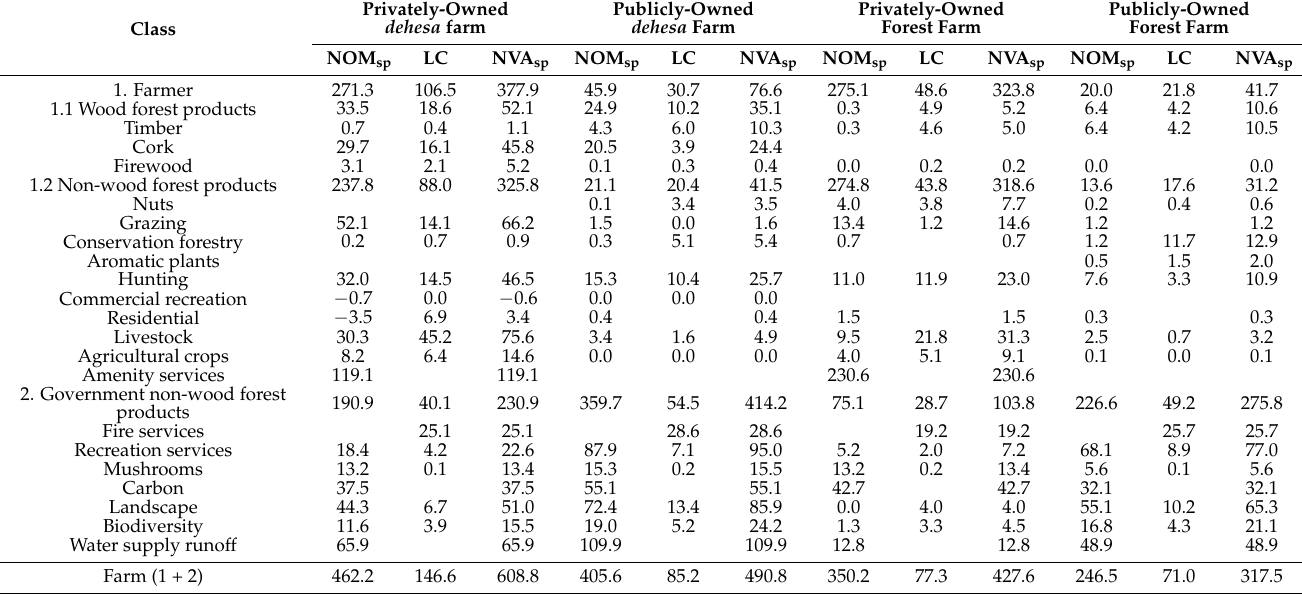
Table 4. Net value added of case-study large dehesa and forest farms in Andalusia under the AAS (2010: € /ha).